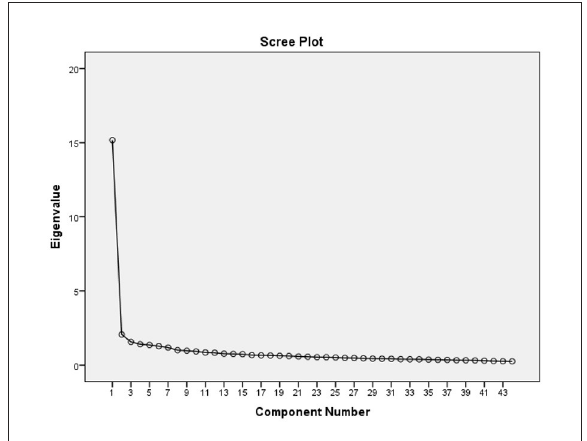
FIGURE1 Scree plot showing Eigenvalue of the factors